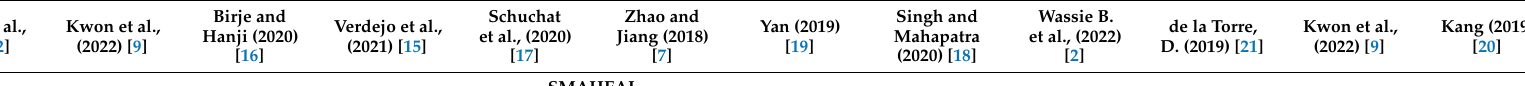
Table 1. The sources of items in the study